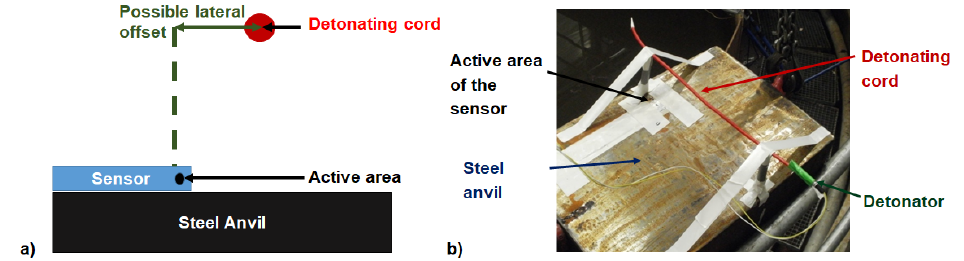
Figure 3. Shielded PVDF sensor stuck with tape on the steel anvil. Detonating cord positioned above with plastic posts and tape. Scheme ( a ) and picture ( b